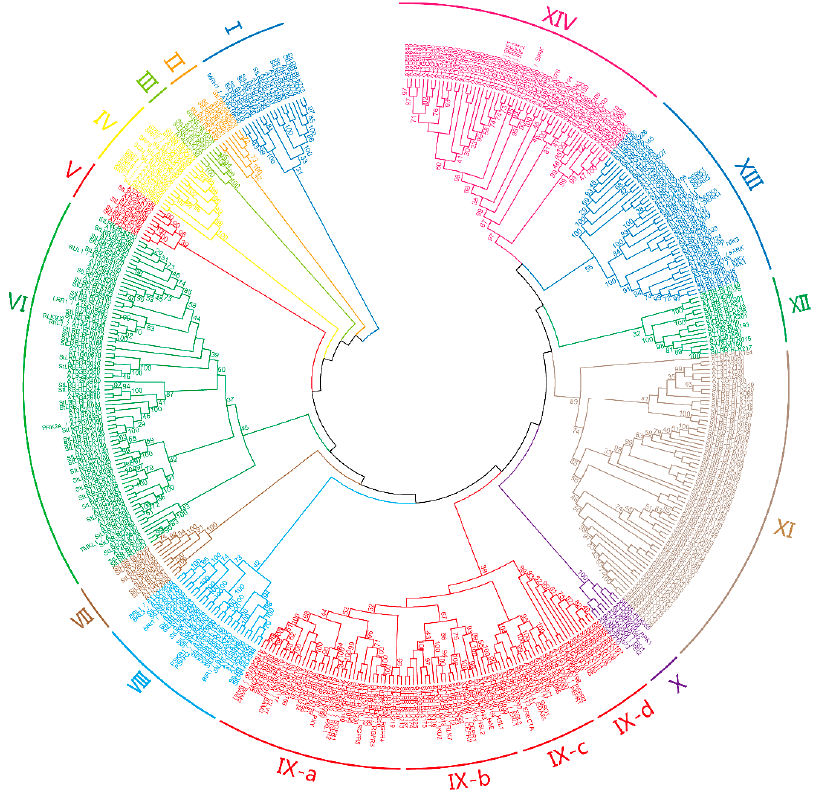
Figure 1. Phylogenetic analysis of LRR-RLK members. The phylogenetic tree was generated from the alignment result of the full-length amino acid sequences by the neighbor-joining (NJ) method. All StLRR-RLK members, together with their Arabidopsis homologues, were classified into 14 distinct subfamilies.